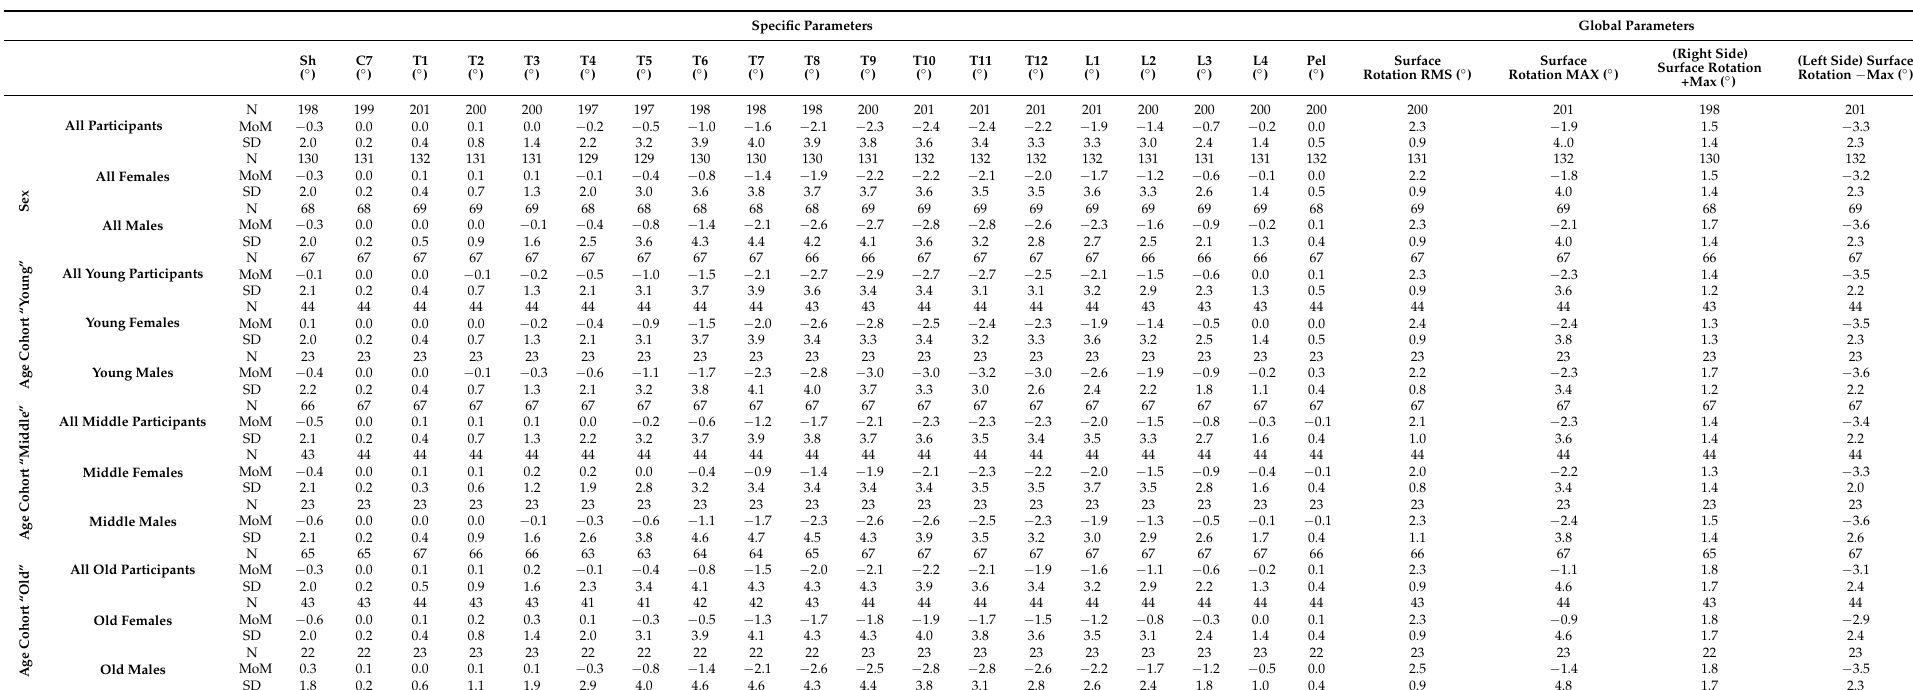
Table 2. Results of the descriptive statistical analyses (MoM ± SD) of the spinal parameters in the transversal